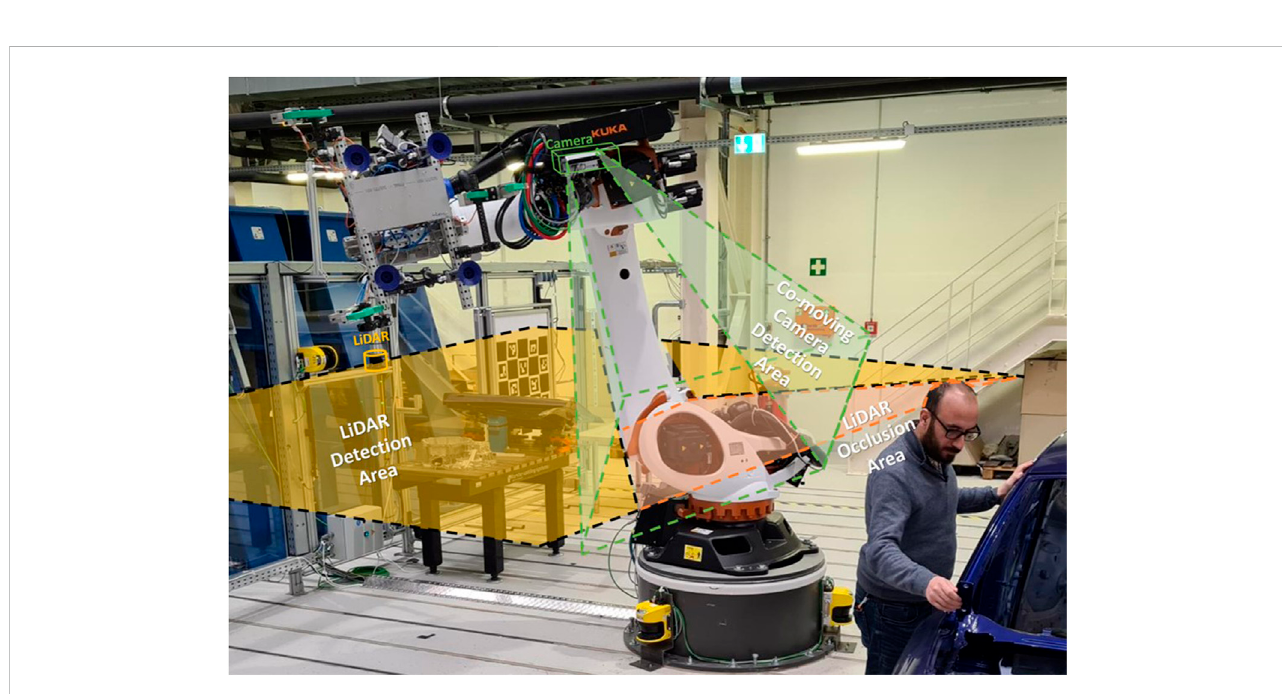
FIGURE 11 Box plot on multiple iterations at multiple robot